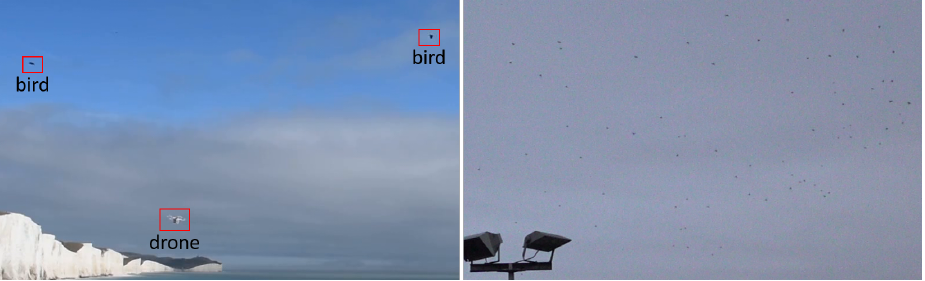
Figure 3. Distribution of drone sizes across the ground truth annotations in the train data.